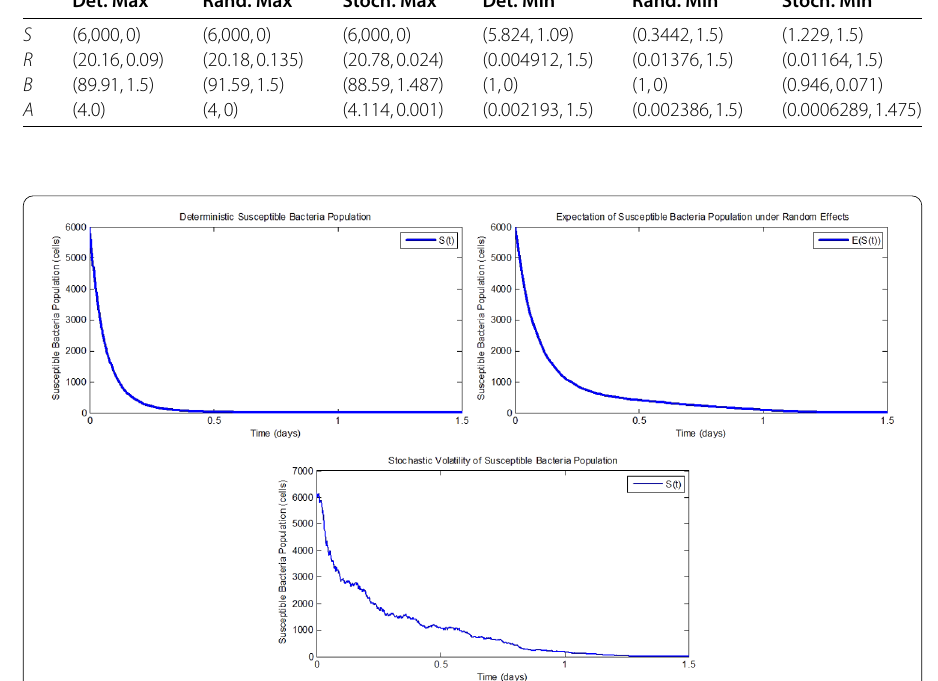
Figure 11 Deterministic, random and stochastic results for S ( t ),